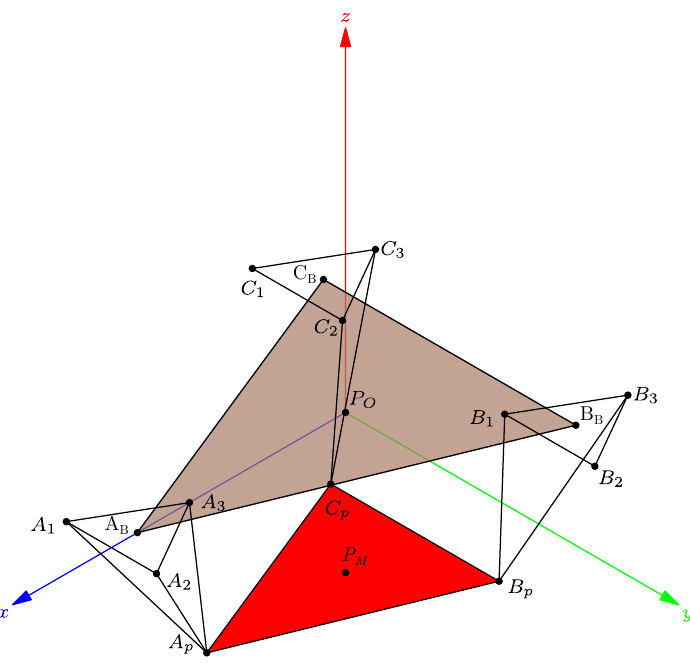
Figure 8. Geometric design of the DWS